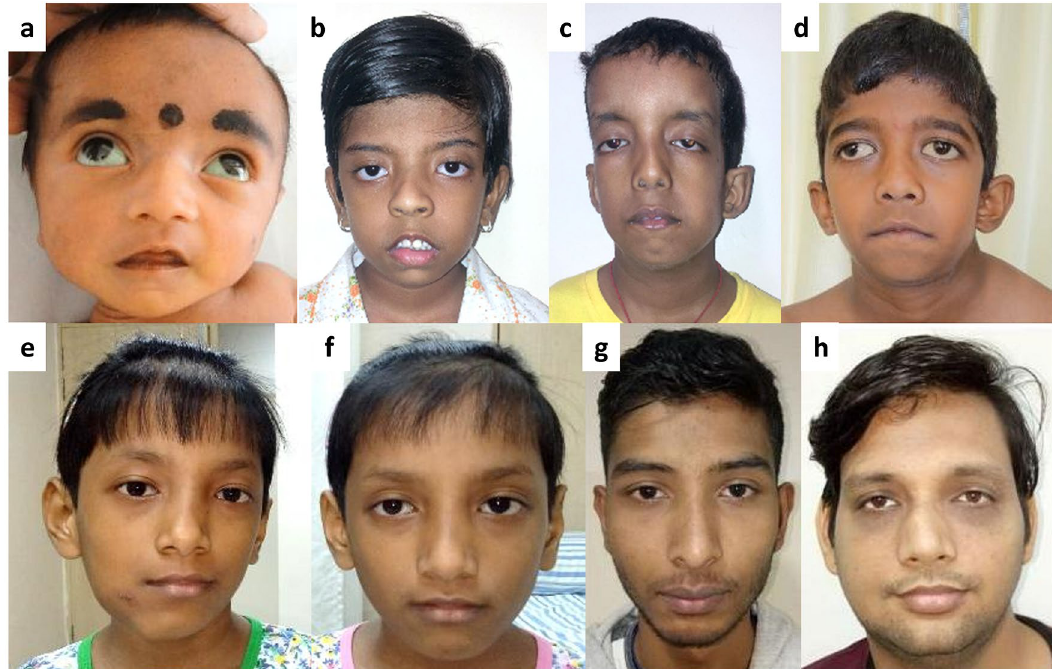
Figure 3. Facial photographs of patients with LDS show long faces, widely spaced eyes, downslanted palpebral fissures, thin vermilion of upper lips and micrognathia in all of them ( a – h ). Additionally, low set ears ( b – d ), ptosis ( b ) and wide mouth with downturned corners ( d ) were noted. Photographs were taken at ages: 7 months ( a : Patient 44), 6 years ( b : Patient 39 and c : Patient 40), 8 years ( d : Patient 42), 9 years ( e : Patient 45 and f : monozygotic twin of Patient 45), 16 years ( g : Patient 41) and 36 years ( h : Patient